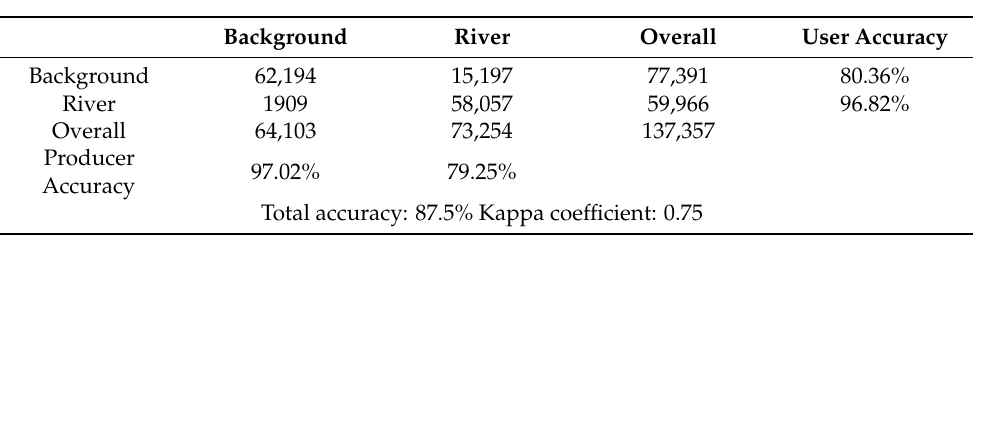
Table 2. Validation of the accuracy of the proposed method (Unit: